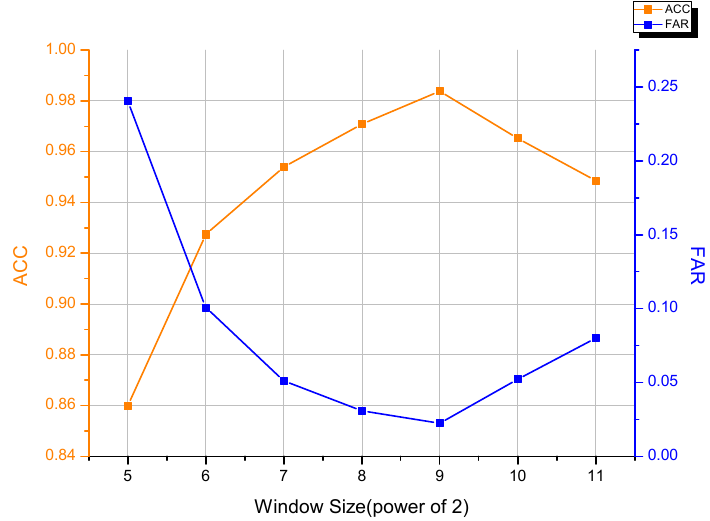
Figure 9. Performance on different window sizes.